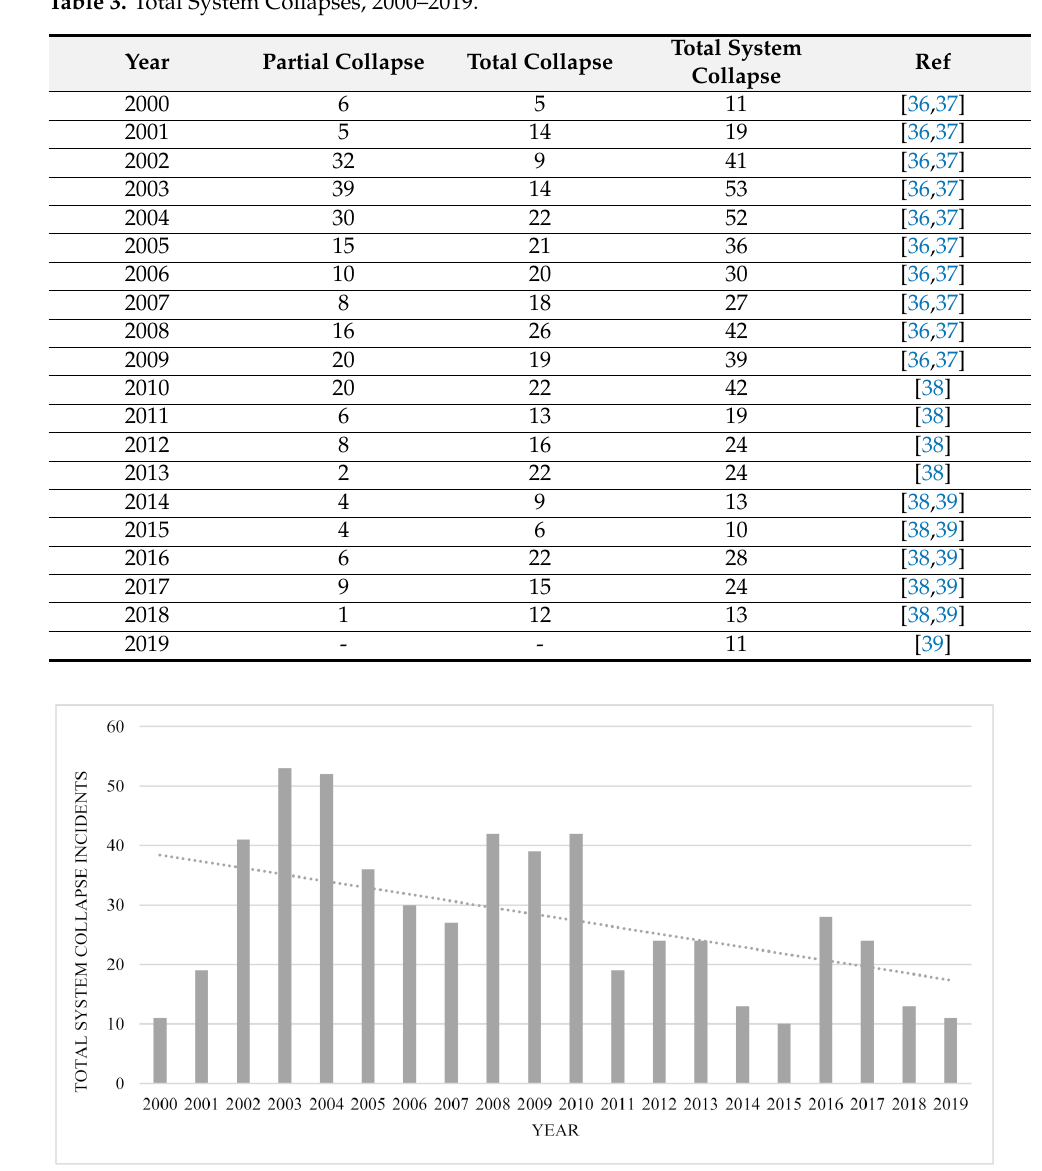
Figure 3. The total system collapse incidents in Nigeria between 2000 and 2019. (Data from Table